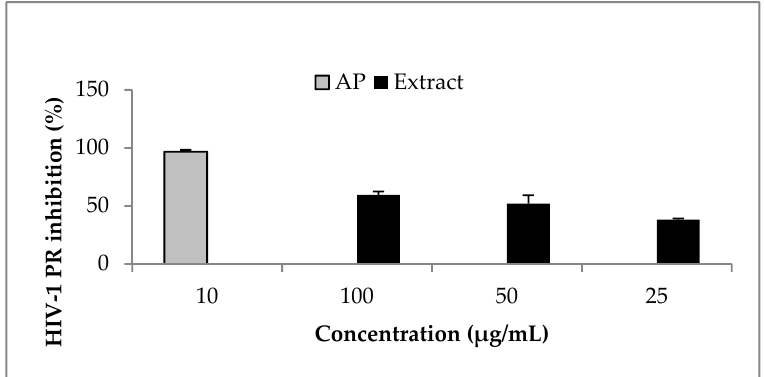
Figure 2. Effect of O. labiatum extract on HIV-1 PR. The extract, fluorogenic substrate and HIV-1 PR were incubated at 37 °C for 1 h. The extract significantly ( p < 0.05) inhibited HIV-1 PR with >50% inhibition at 50 and 100 μ g/mL. Acetyl pepstatin (AP) a known protease inhibitor was used as control (10 μ g/mL = 15.5 μ M).